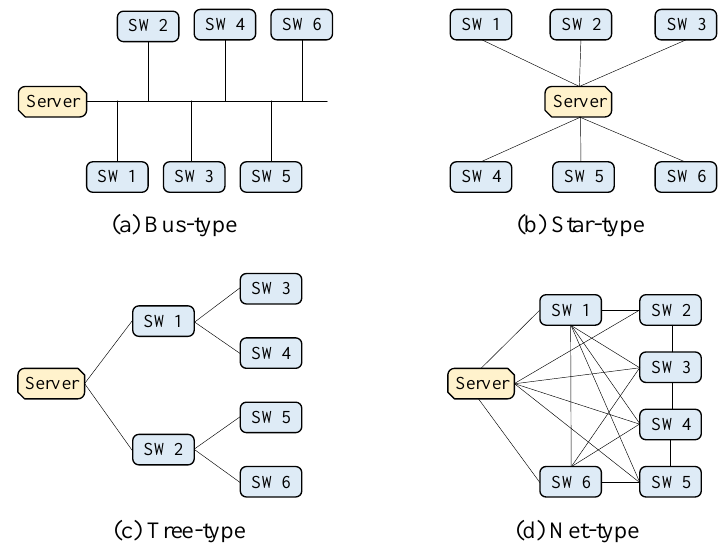
Figure 20. Schematic diagram of access network structure.